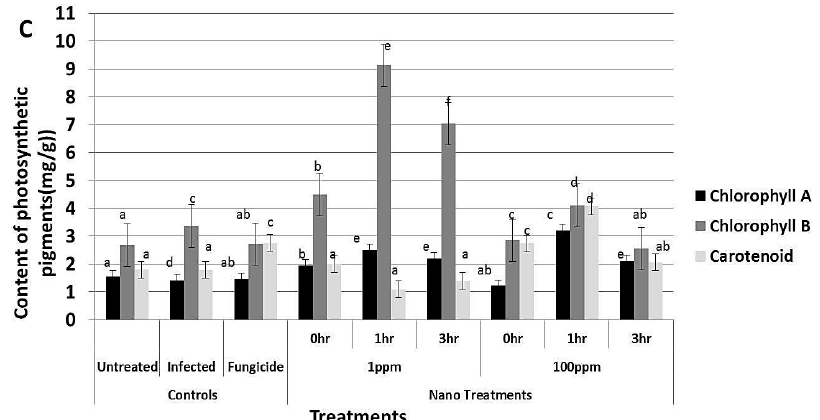
Figure 12. E ff ect of rGO-CuO NP treatments on photosynthetic pigments of treated ( A ) tomato and ( B , C ) pepper plants (nine biological replicates). Two independent experiments with pepper plants are plotted. Letters on bars mean statistically significant differences between the mean of the respective control and the nanocomposite at the same concentration ( p ˂ 0.05).